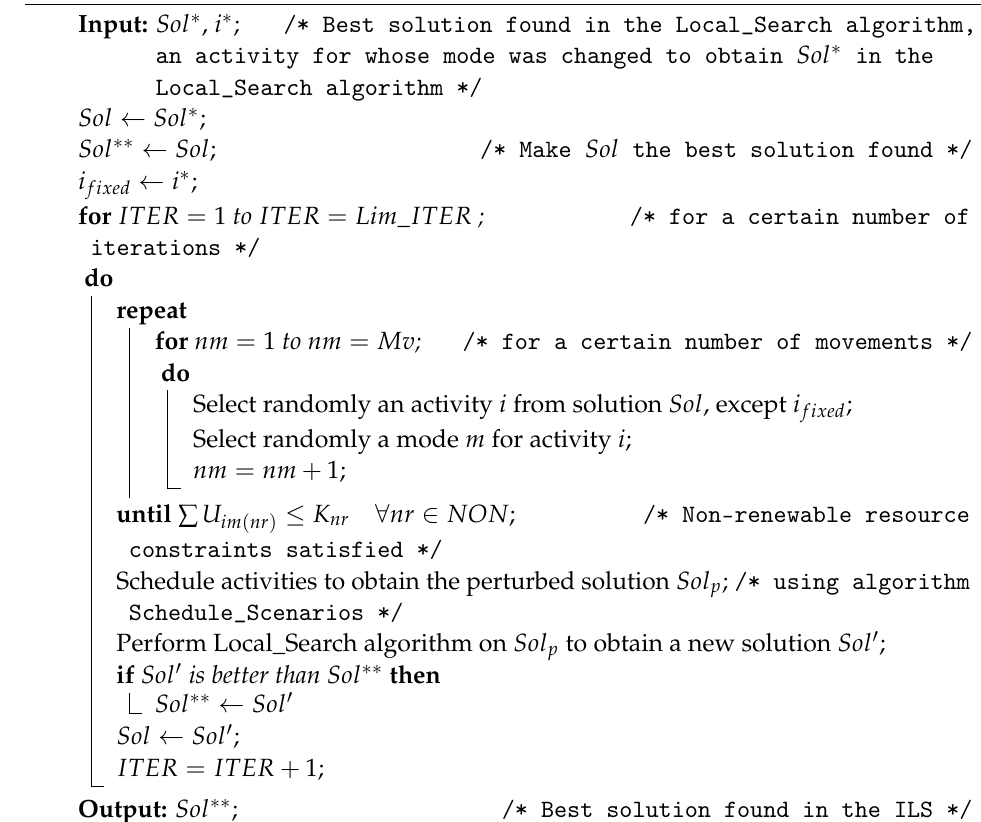
Algorithm 4: Perturbation. Algorithm for the perturbation